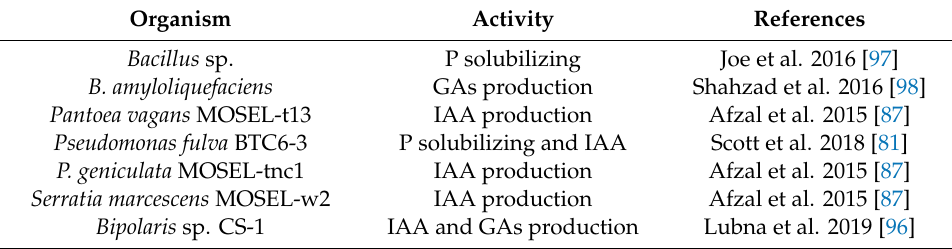
Table 1. Plant growth promoting bacteria and fungi associated with cannabis and their mode of action.